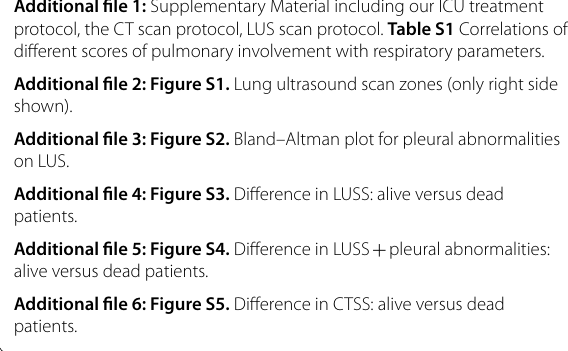
Additional file 3: Figure S2. Bland–Altman plot for pleural abnormalities on LUS. Additional file 4: Figure S3. Difference in LUSS: alive versus dead patients. Additional file 5: Figure S4. Difference in LUSS alive versus dead patients. Additional file 6: Figure S5. Difference in CTSS: alive versus dead patients.